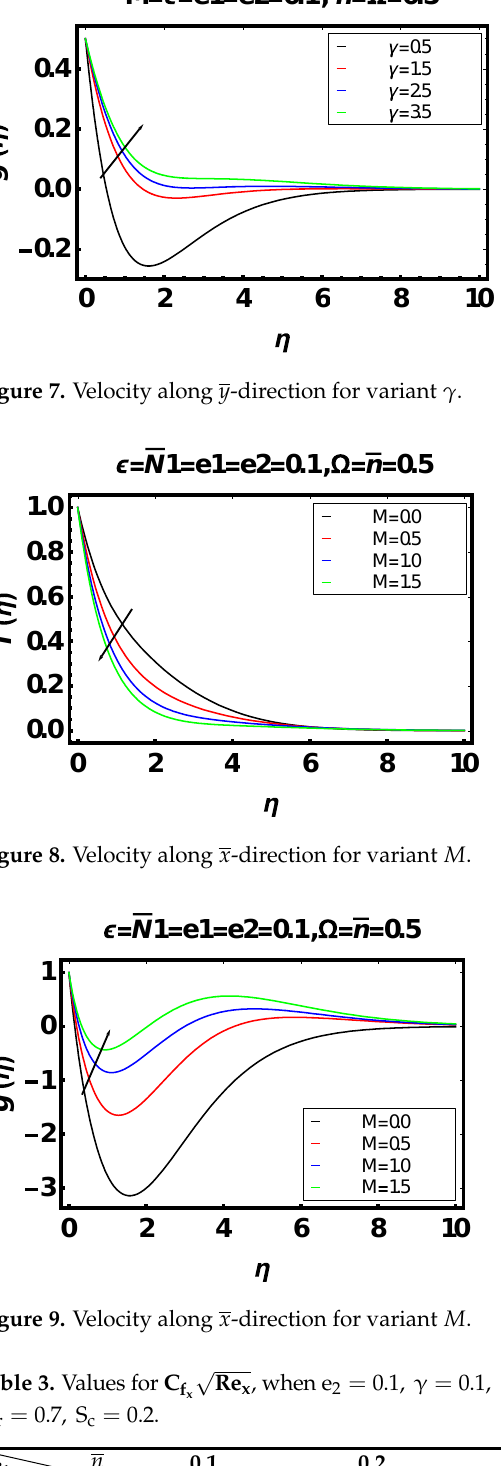
Figure 6. Velocity along 𝑥̅ -direction for variant 𝛾.